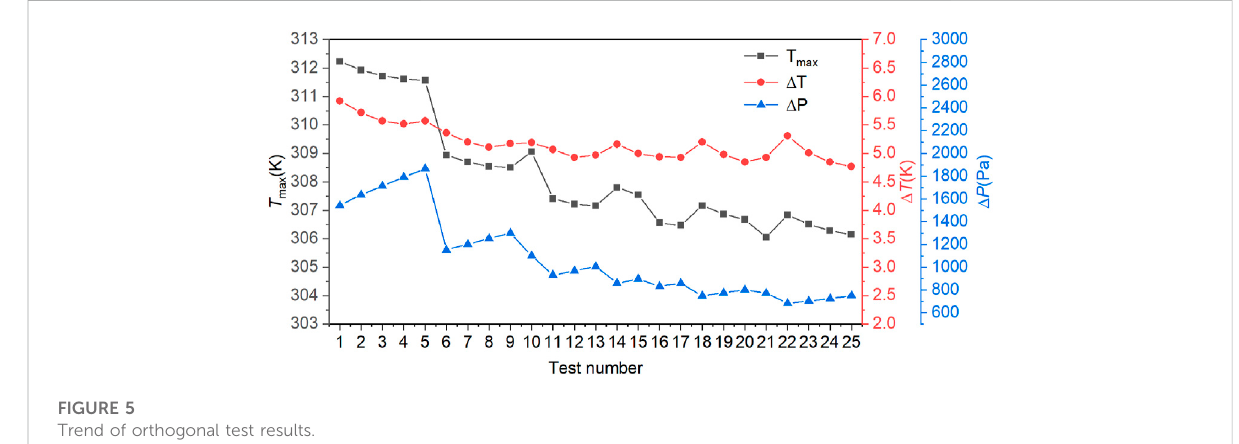
FIGURE 5 Trend of orthogonal test